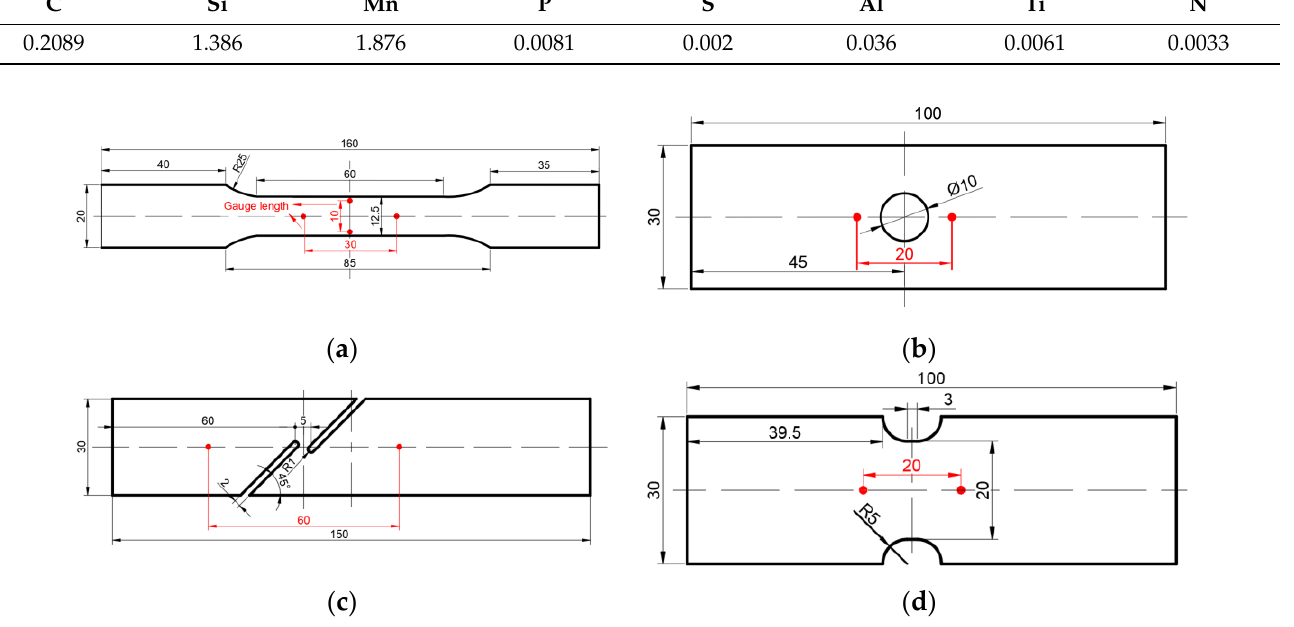
Figure 1. Four types of specimens [unit: mm]: ( a ) dog-bone specimen; ( b ) specimen with a central hole; ( c ) in-plane shear specimen; ( d ) notched specimen. Table 1. Chemical compositions of QP980steel sheet (wt %).